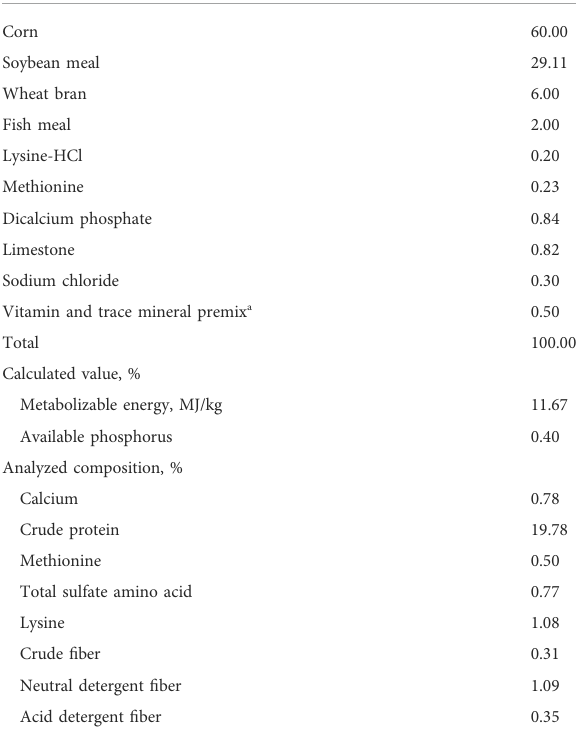
TABLE 1 Composition and nutrient levels of the experimental basal diet (%, as-fed basis). Ingredients,